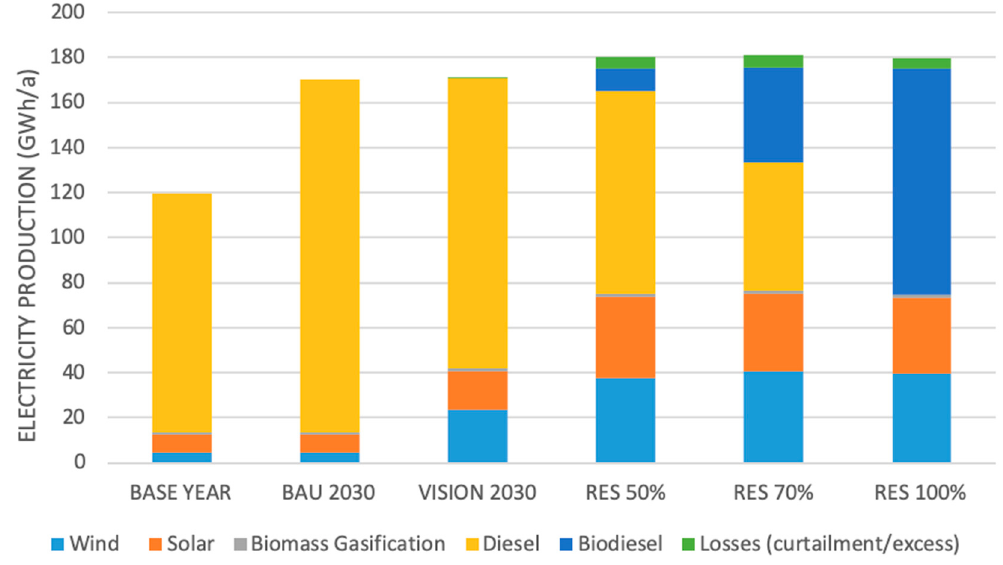
Figure 10. Annual electricity production (GWh) for base year and future scenarios.